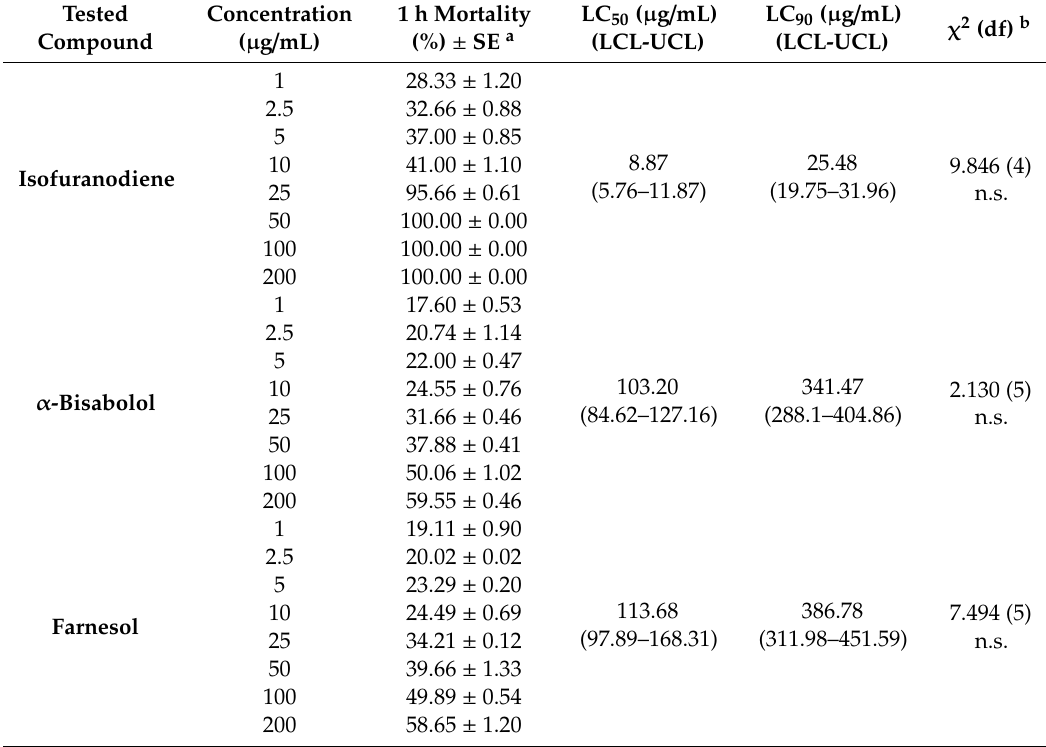
Table 1. Lethal concentrations (LC 50 and LC 90 values) of isofuranodiene, bisabolol, and farnesol against Echinococcus granulosus